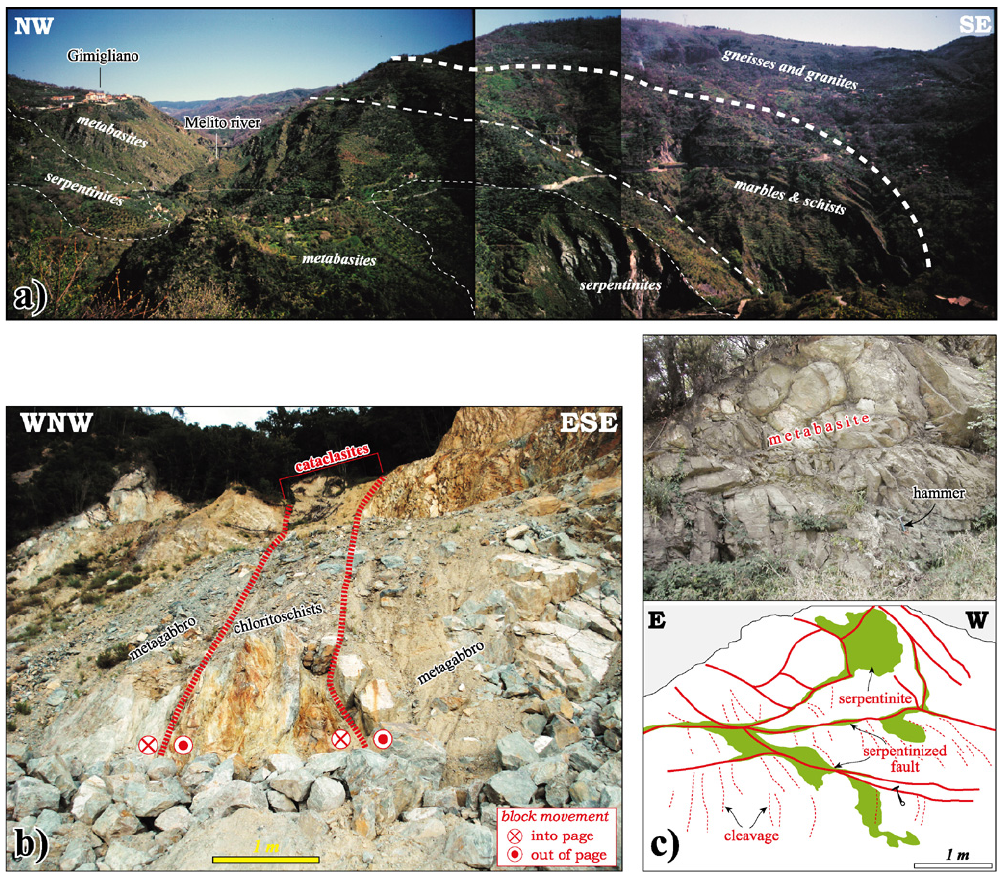
Fig. 4. (a) View of a tectonic window in Calabria region (southern Italy), where ophiolitic sequences are bounded from overlying continental basement units by tectonic contacts (after Rossetti et al., 2001); (b) metagabbros with sheared zone of foliated chloritoschists (Ligurian Alps, Italy); (c) picture and line-drawing of massive metabasite with pervasive serpentinized fault systems (Ligurian Alps,